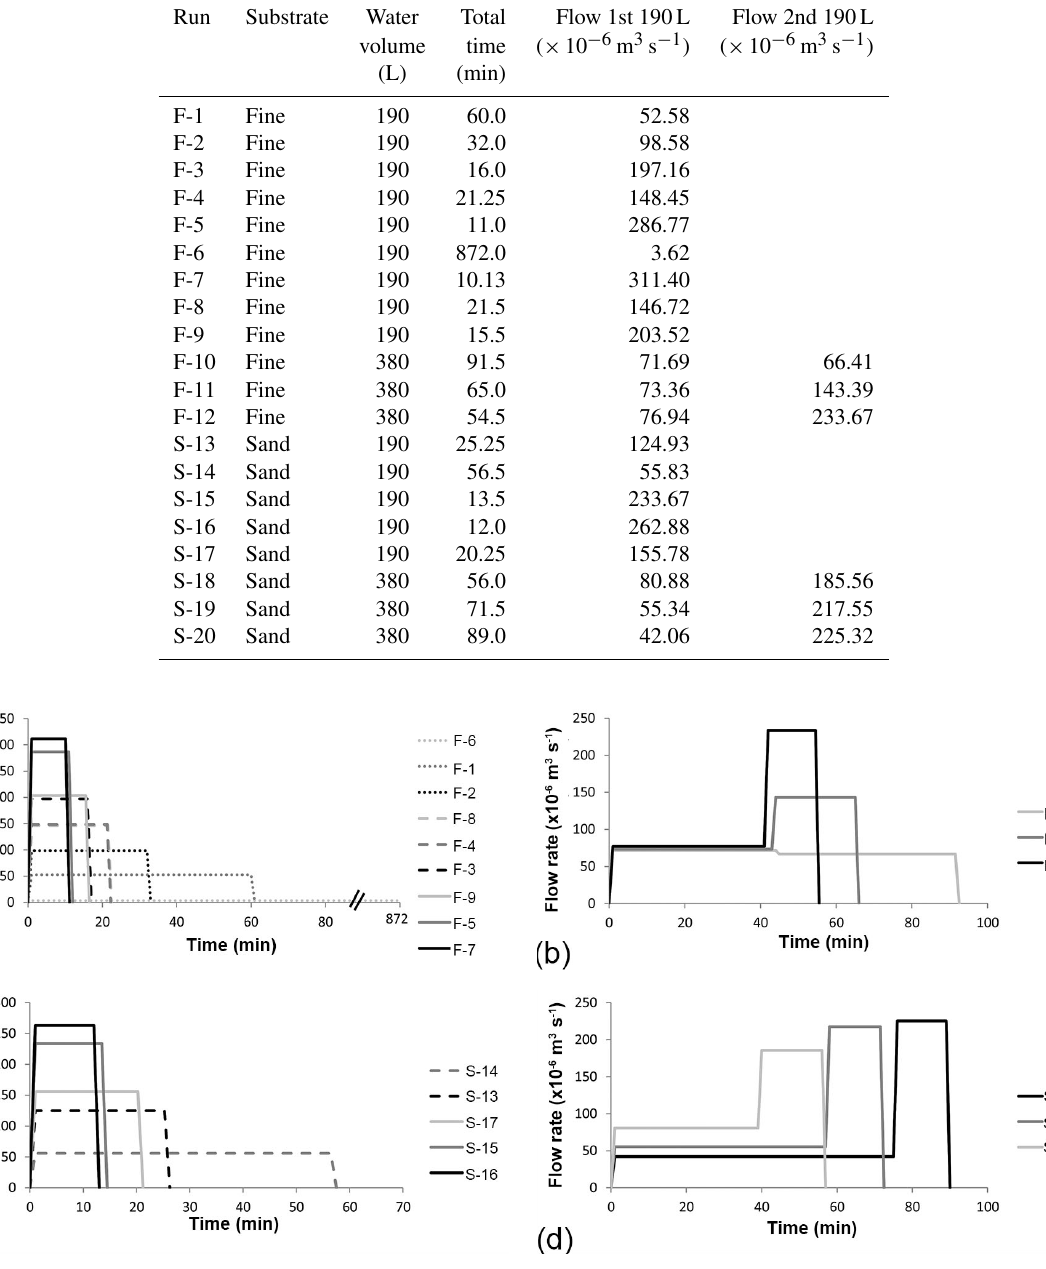
Figure 2. These hydrographs show the range of flow rates tested. Each set of curves is for a separate set of experimental runs: (a) 190L of water over the fine-grained substrate, (b) 380L of water over the fine-grained substrate, (c) 190L of water over the sand substrate, (d) 380L of water over the sand